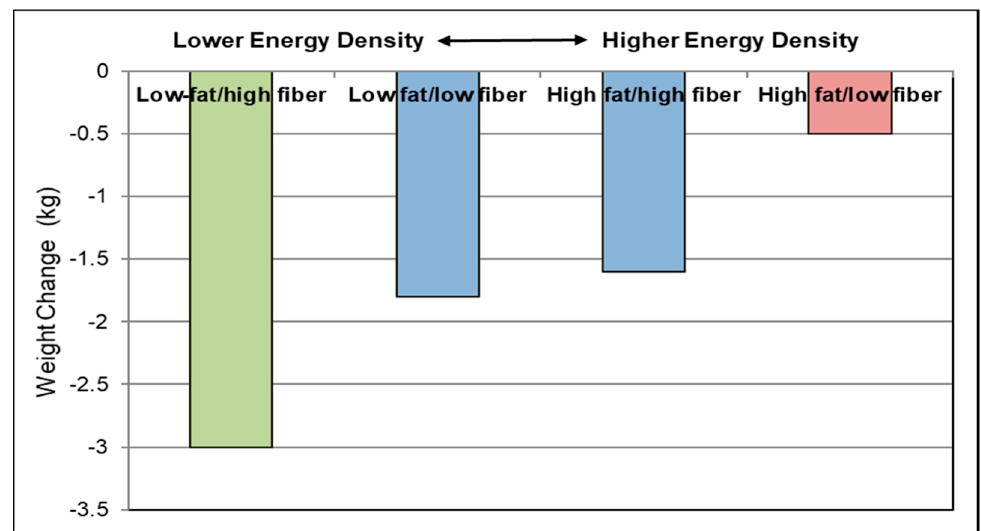
Figure 6. Effect of dietary energy density associated with various levels of fat and fiber intake on body weight in overweight and obese pre-diabetic adults over 3 years in an intensive dietary and exercise program (fiber range 10.9 to 15.6 g/1000 kcal and fat range from <30 to >36.9% energy) [119].